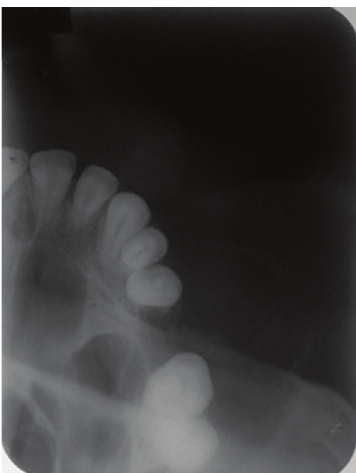
Figure 5: Occlusal view shows a circular radiolucency with a thin discontinuous cortication present on the buccal aspect of the maxilla.